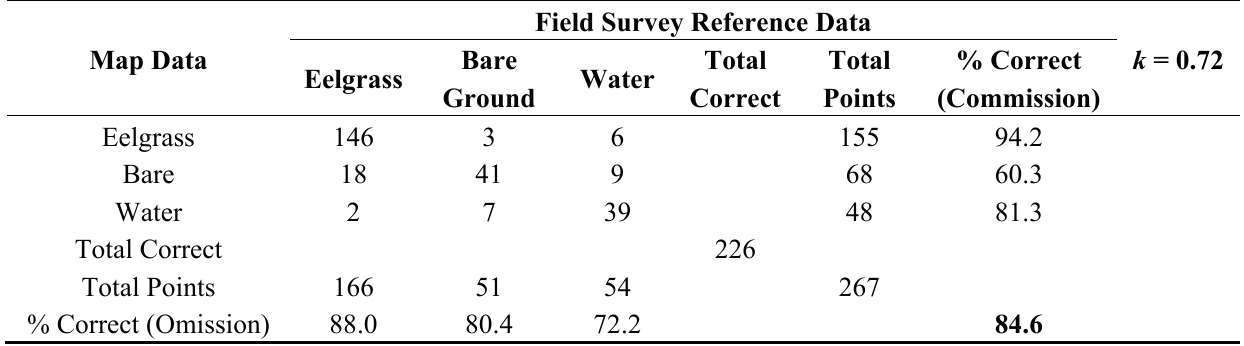
Table A2. Final product for classification of habitats in Izembek Lagoon.